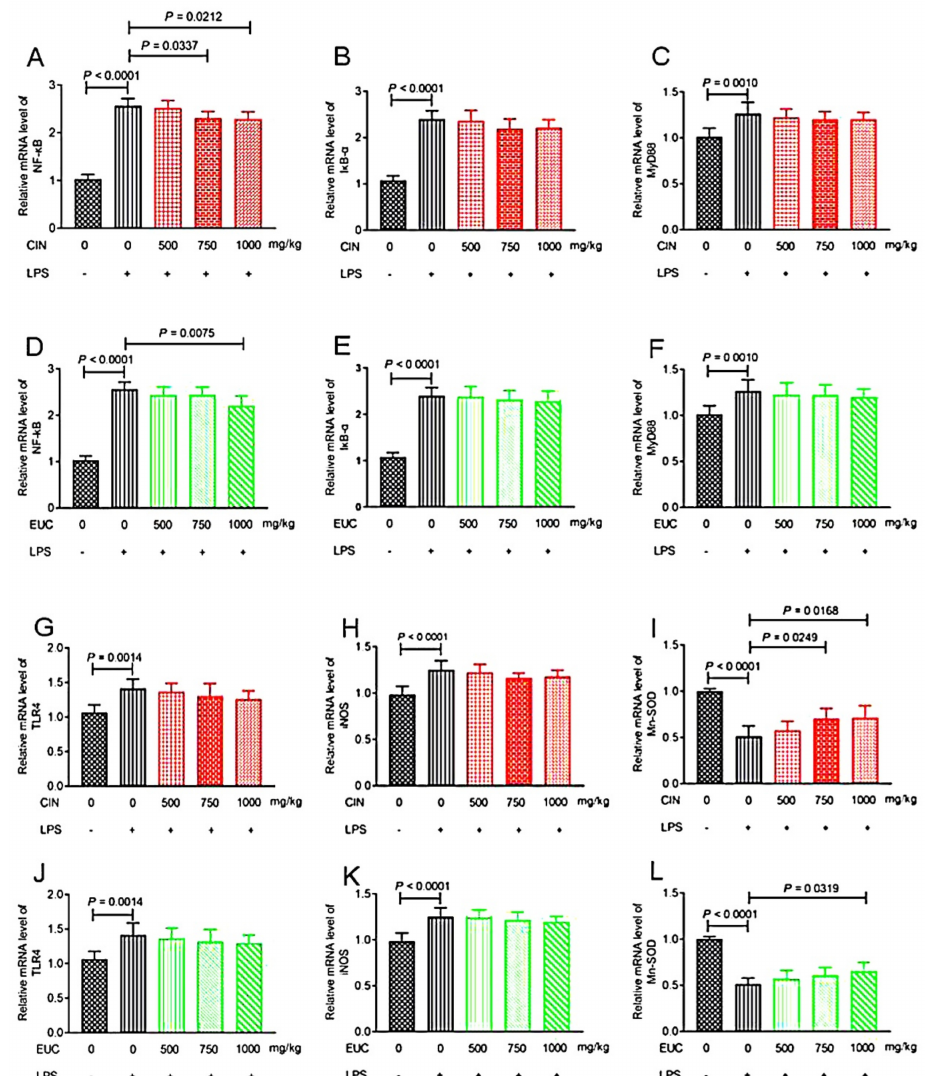
Figure 3. The effect of EOs on the expression of inflammation-related genes in the liver. Effects of cinnamon oil on LPS-induced mRNA expression levels of NF- κ B ( A ), I κ B- α ( B ), MyD88 ( C ), TLR4 ( G ), iNOS ( H ), and Mn-SOD ( I ) in mice. Effects of eucalyptus oil on LPS-induced mRNA expression levels of NF- κ B ( D ), I κ B- α ( E ), MyD88 ( F ), TLR4 ( J ), iNOS ( K ), and Mn-SOD ( L ) in concentration of LPS induced in mice was 10 mg/kg. The concentration of cinnamon oil and eucalyptus oil were 500 mg/kg, 750 mg/kg, and 1000 mg/kg, respectively. CIN—cinnamon oil; EUC—eucalyptus